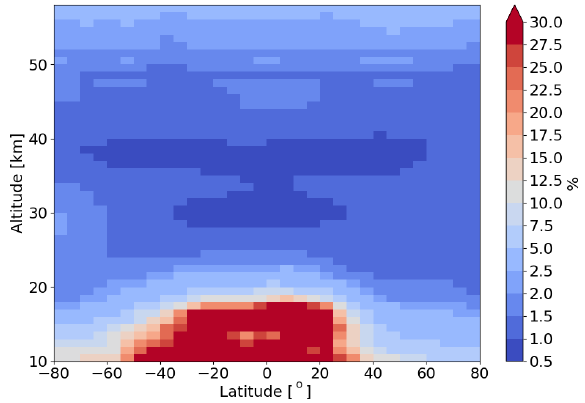
Figure 1. Monthly and zonally averaged retrieval noise for March 2016 as a function of altitude and